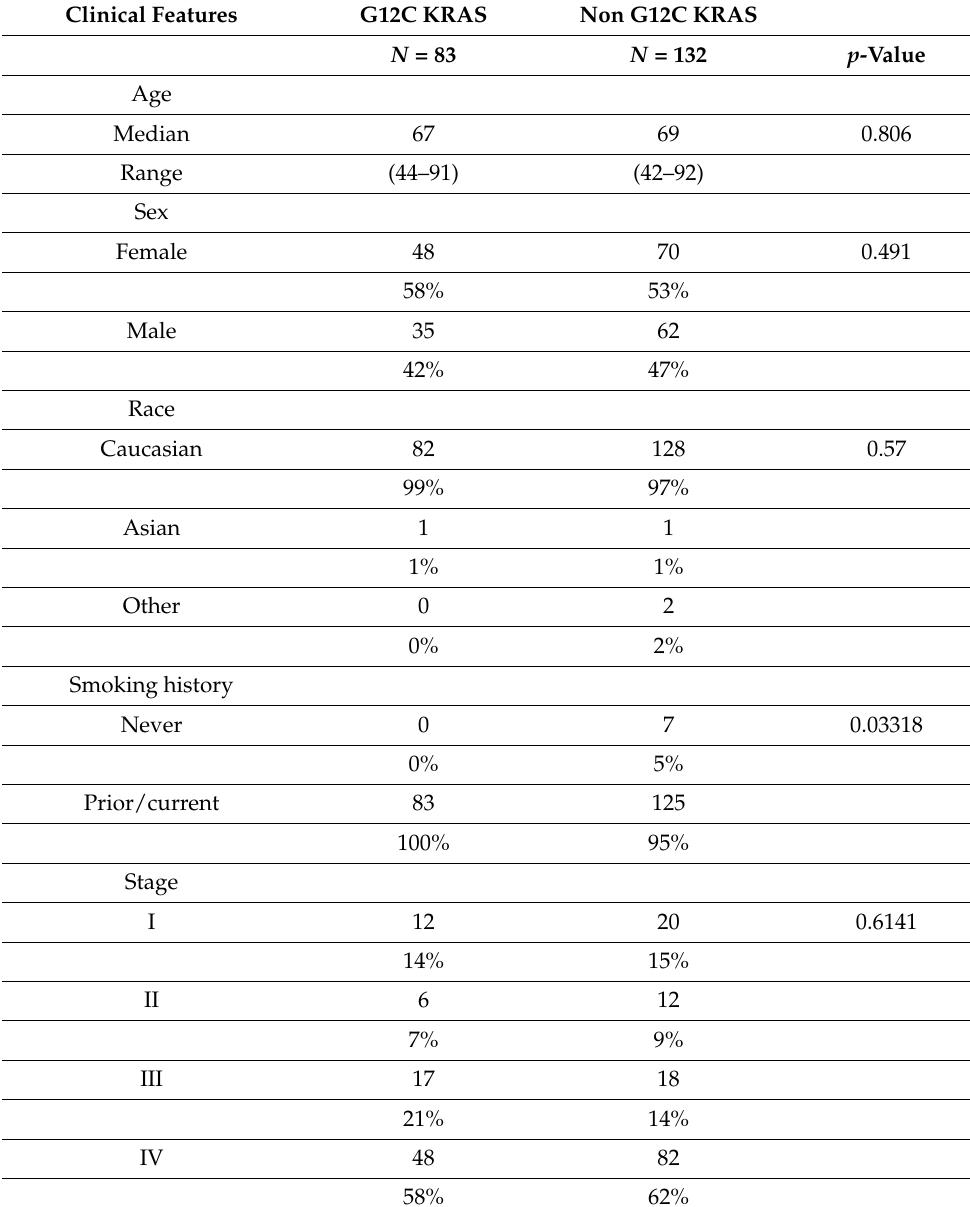
Table 1. Clinical features of G12C KRAS and non-G12C KRAS